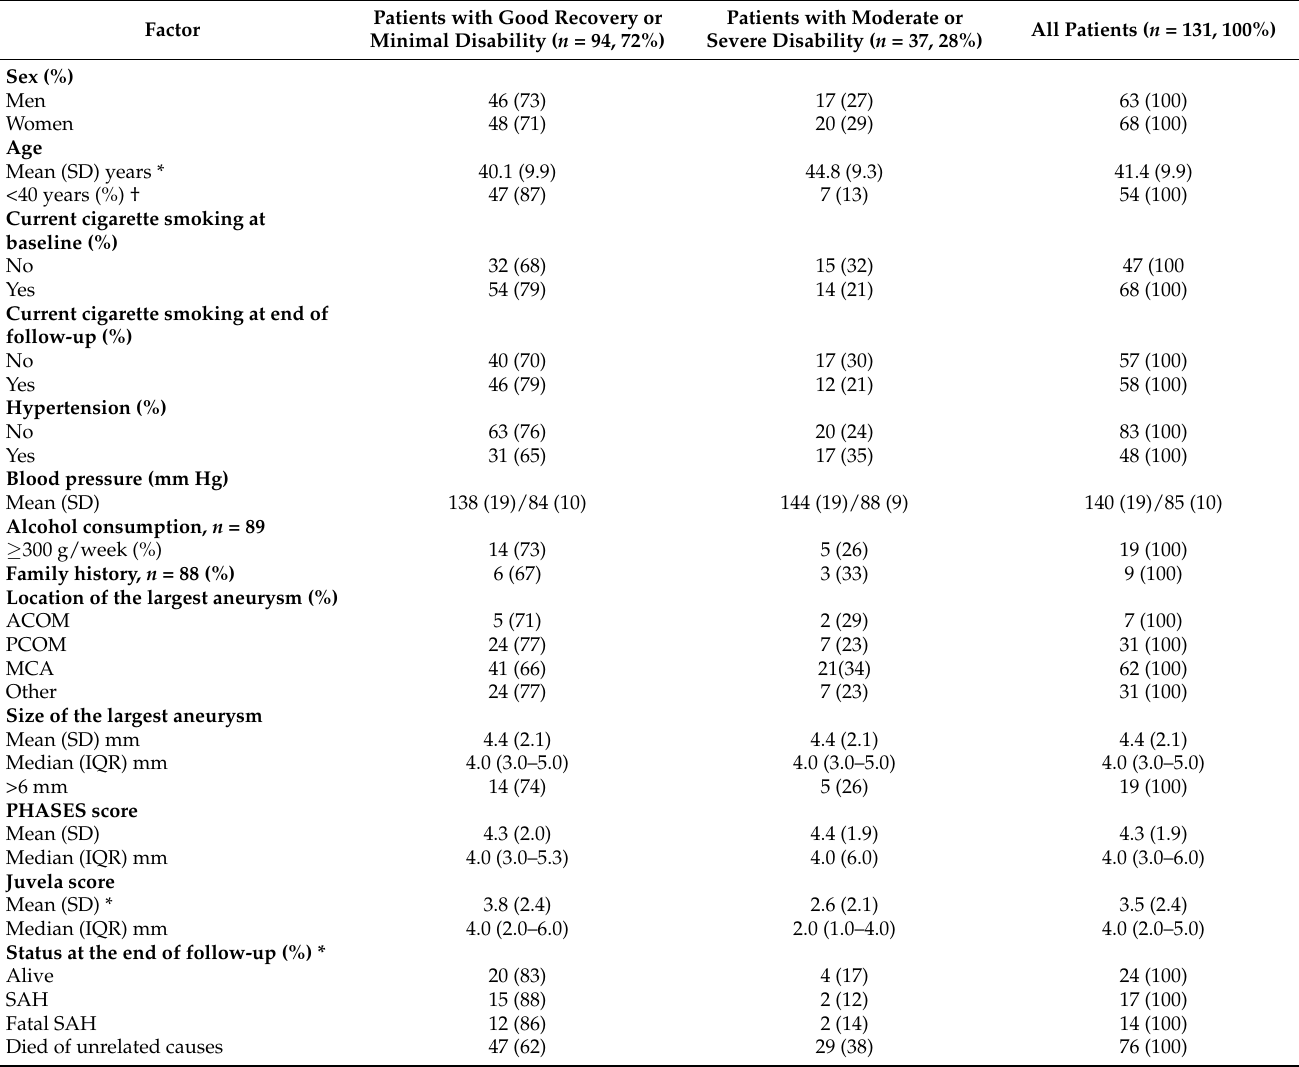
Table 1. Baseline characteristics, follow-up status and outcome after prior